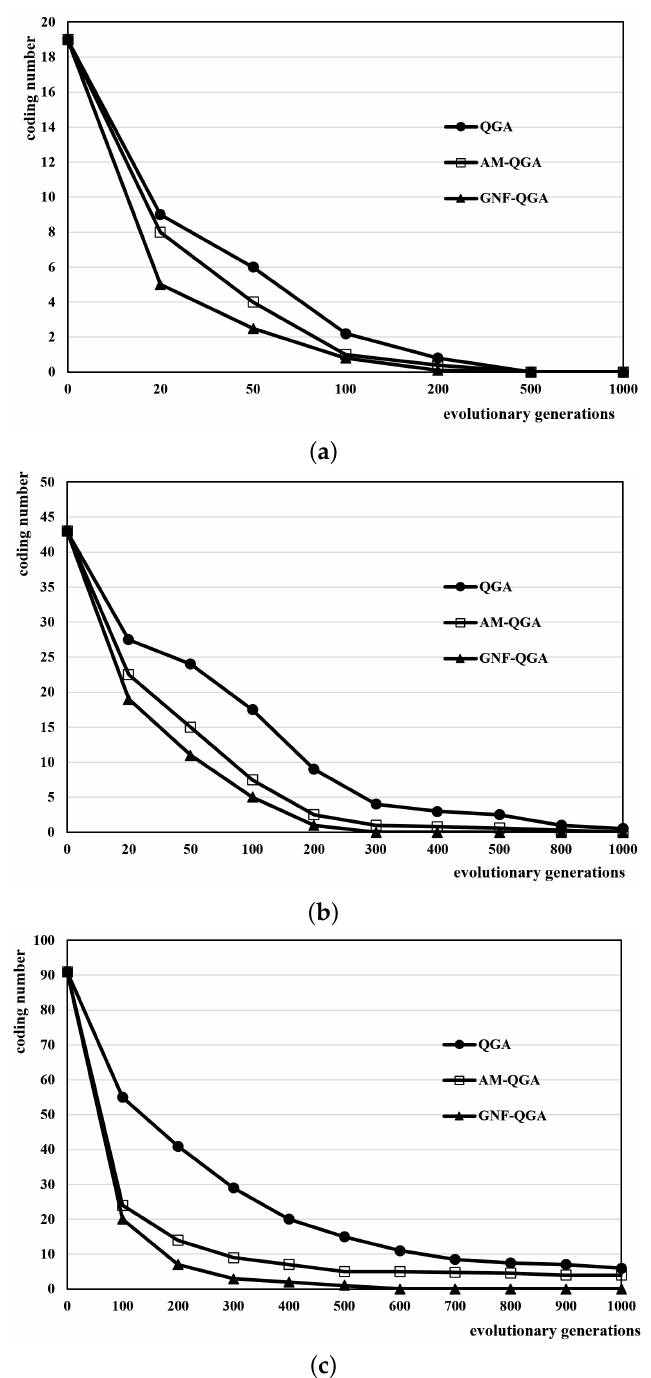
Figure 10. Comparison of evolution generations and coding numbers for different